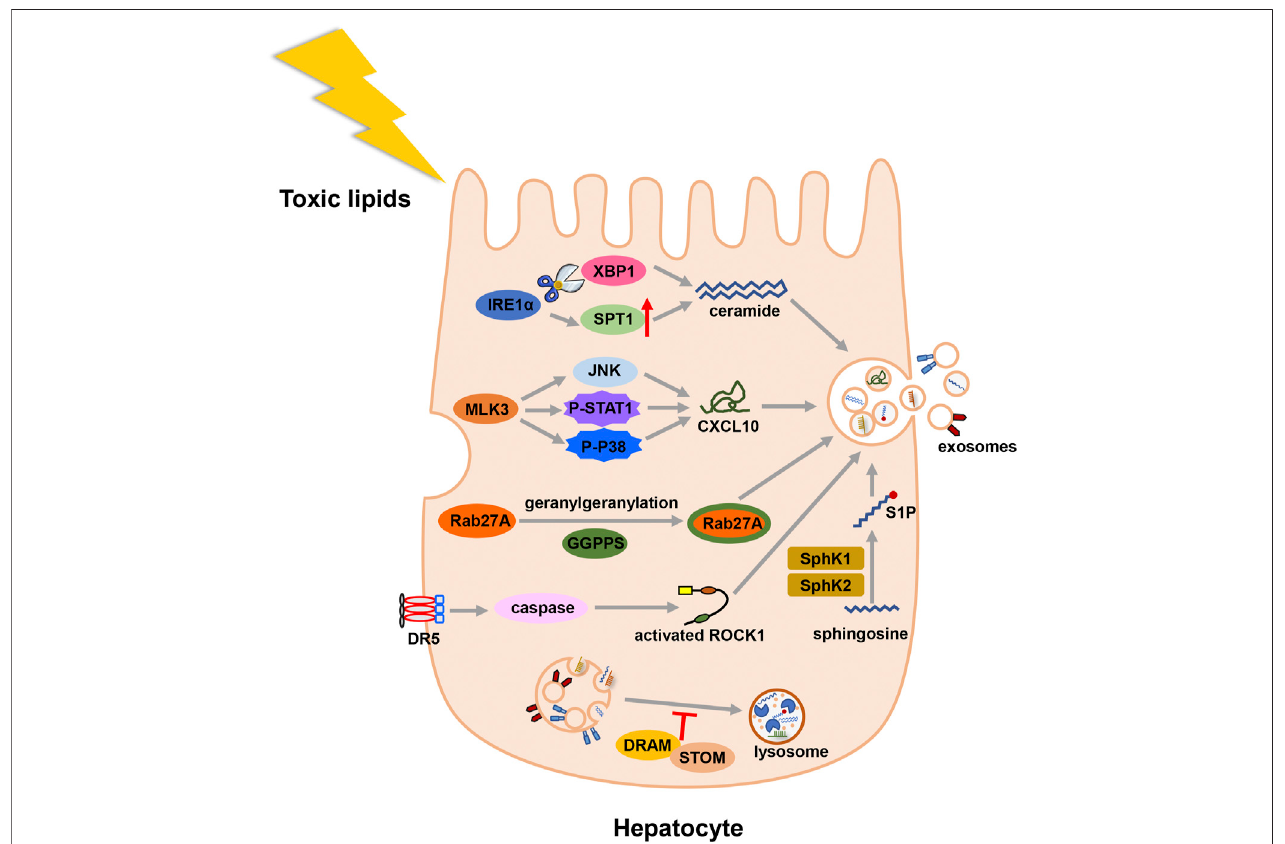
FIGURE2| IllustrationforthebiogenesisfoexosomesinMAFLD.Toxiclipidaccumulation isthemajorhitofMAFLD,whichcausesmoresecretionofexosomesby multiple mechanisms. Abbreviation: death receptor 5 (DR5), Rho-associated kinase 1 (ROCK1), geranylgeranyl diphosphate synthase (Ggpps), mixed lineage kinase 3 (MLK3), (C-X-C motif) ligand 10 (CXCL10), inositol requiring enzyme 1 α (IRE1 α ), X-box binding protein-1 (XBP1), serine palmitoyltransferase1 (SPT1), sphingosine-1- phosphate (S1P), sphingosine kinase 1 (SphK1), and sphingosine kinase 2 (SphK2), damage-regulated autophagy modulator (DRAM), stomatin